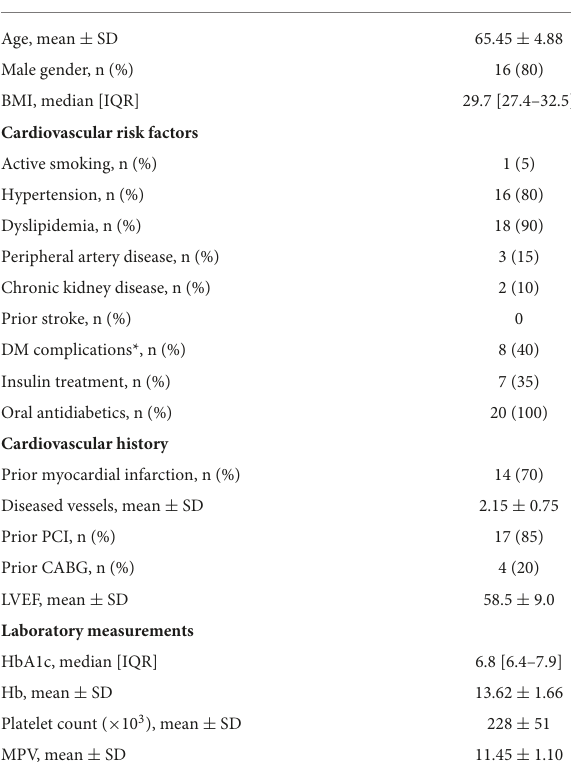
TABLE 1 Baseline